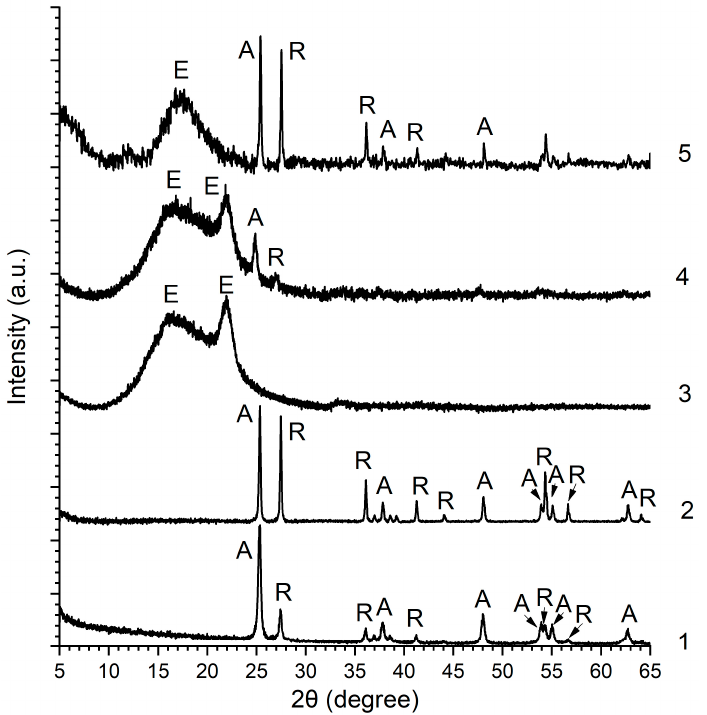
Figure 5. XRD patterns: 1—TiO 2 ( d av = 46 nm); 2—TiO 2 ( d av = 100 nm); 3—cured epoxy; 4—TiO 2 /EP of System I (4 wt. % TiO 2 ); and 5—TiO 2 /EP of System II (4 wt. % TiO 2 ). The following symbols are used: A—anatase, R—rutile, and E—cured epoxy